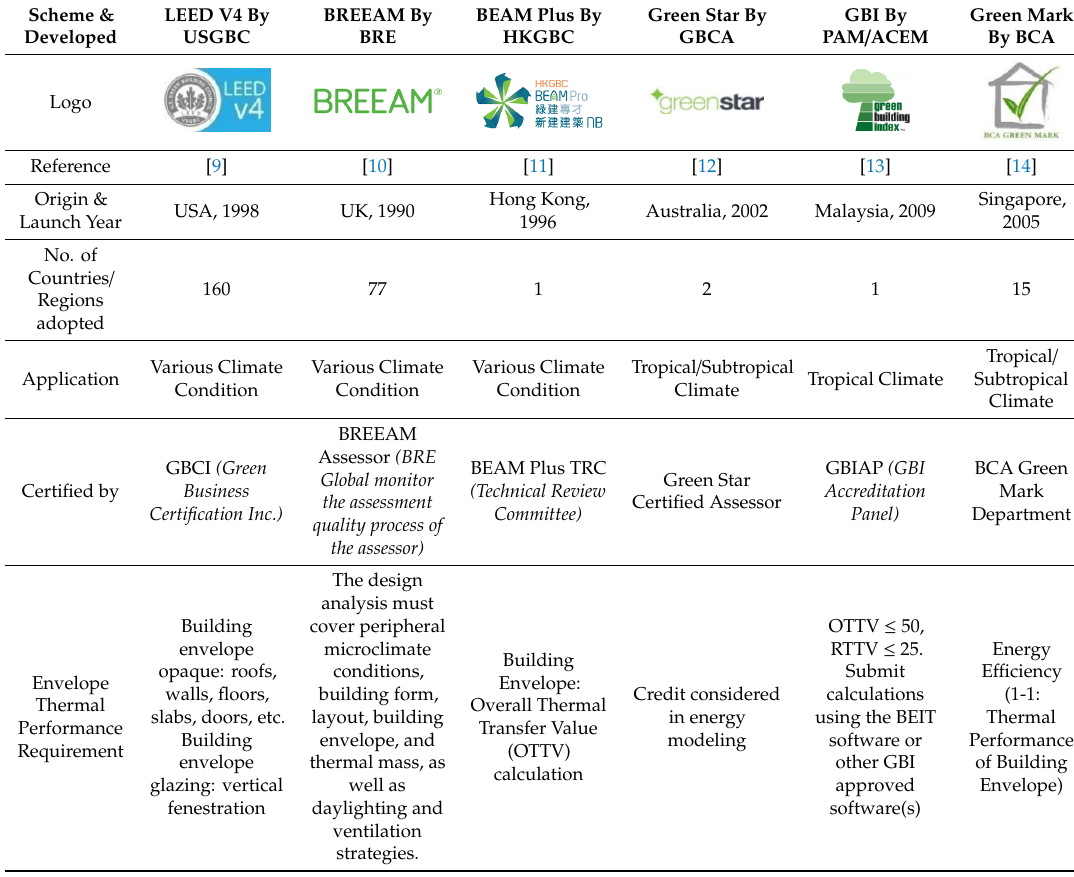
Table 1. Comparison of various green building certifications.